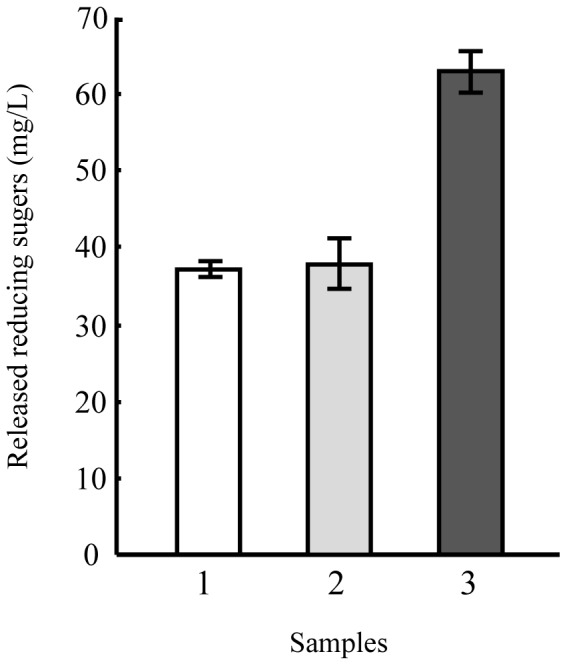
Synergism of cellulase in the presence of the CelA enzyme.The reaction mixture (200 µl final volume) contained 0–1 mg Accellerase 1500 protein per g of Avicel, 1.0% (w/v) Avicel, and 0–10 mg CelA protein per g of Avicel in 0.05M acetate buffer (pH 5.0). The mixture was shaken at 50°C for 1 h before quantification of reducing sugars; sample 1, cell lysate of the E. coli BL21 cells harboring plasmid pET28, sample 2, cell lysate of the E. coli BL21 cells producing recombinant FX003685 enzyme.